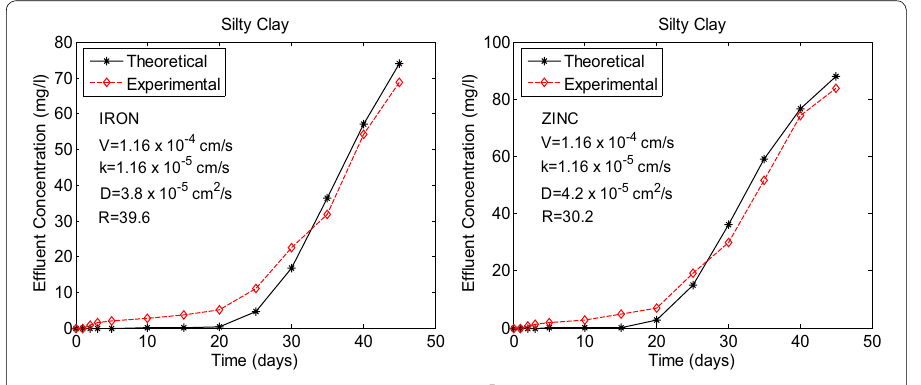
Fig. 7 Migration of ions through silty clay